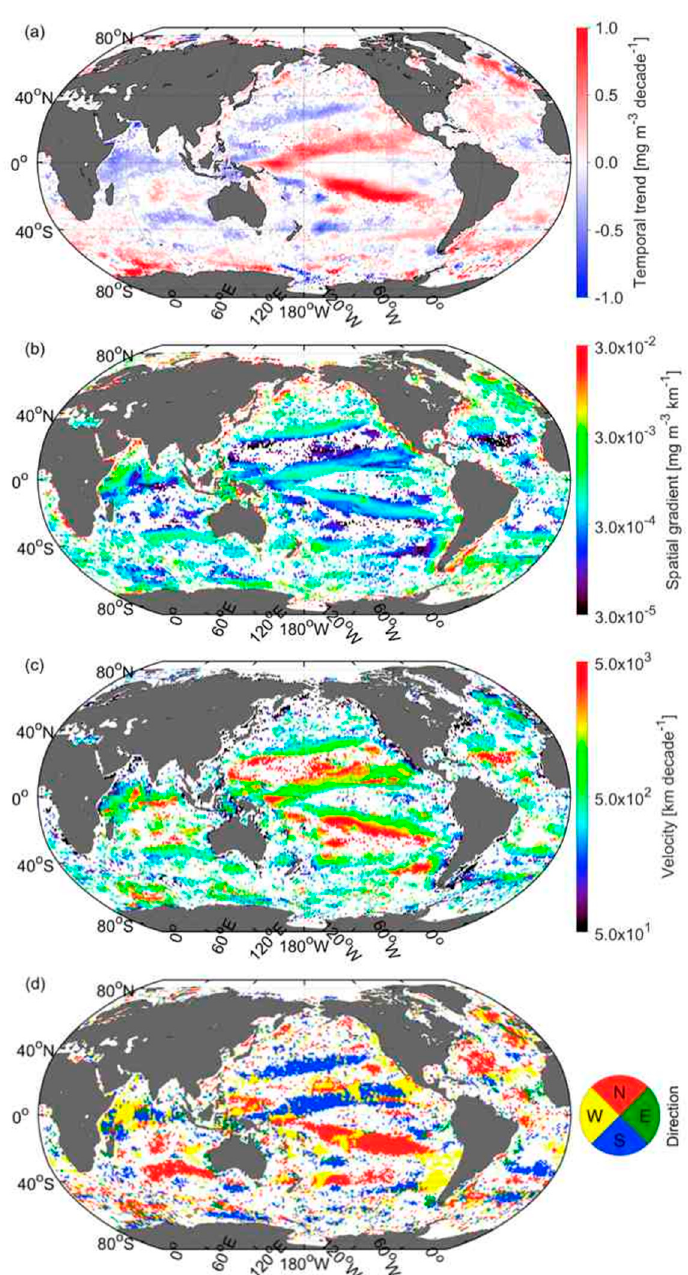
Figure 9. Global distribution of: ( a ) temporal trend; ( b ) spatial gradient; ( c ) velocity; and ( d ) direction of Chl a . White shows the area with non-significant ( p > 0.05) temporal trend for the period 2003–2015.